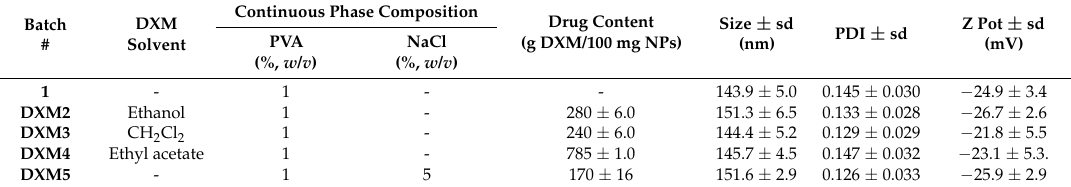
Table 1. Physicochemical properties of GE11-PLGA/PEG-PLGA blend NPs batches: DXM content, size, polydispersity index (PDI) and Zeta potential (Z pot). Results are expressed as mean ± standard deviation (sd).